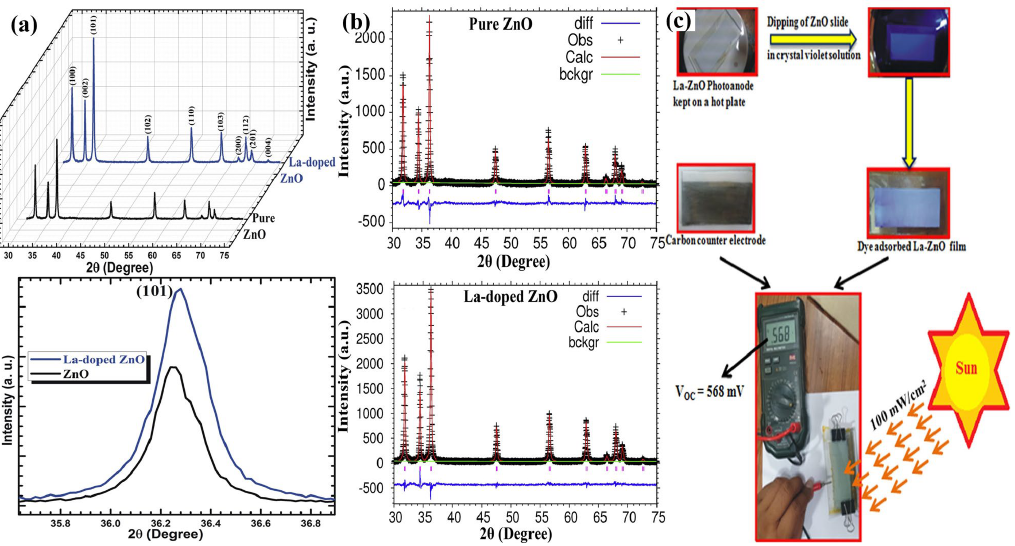
Figure 9. ( a ) and ( b ) are the XRD of pure ZnO and La-ZnO. ( c ) The application of DSSC. Reprinted with permission from [57] © 2017 Elsevier Ltd.